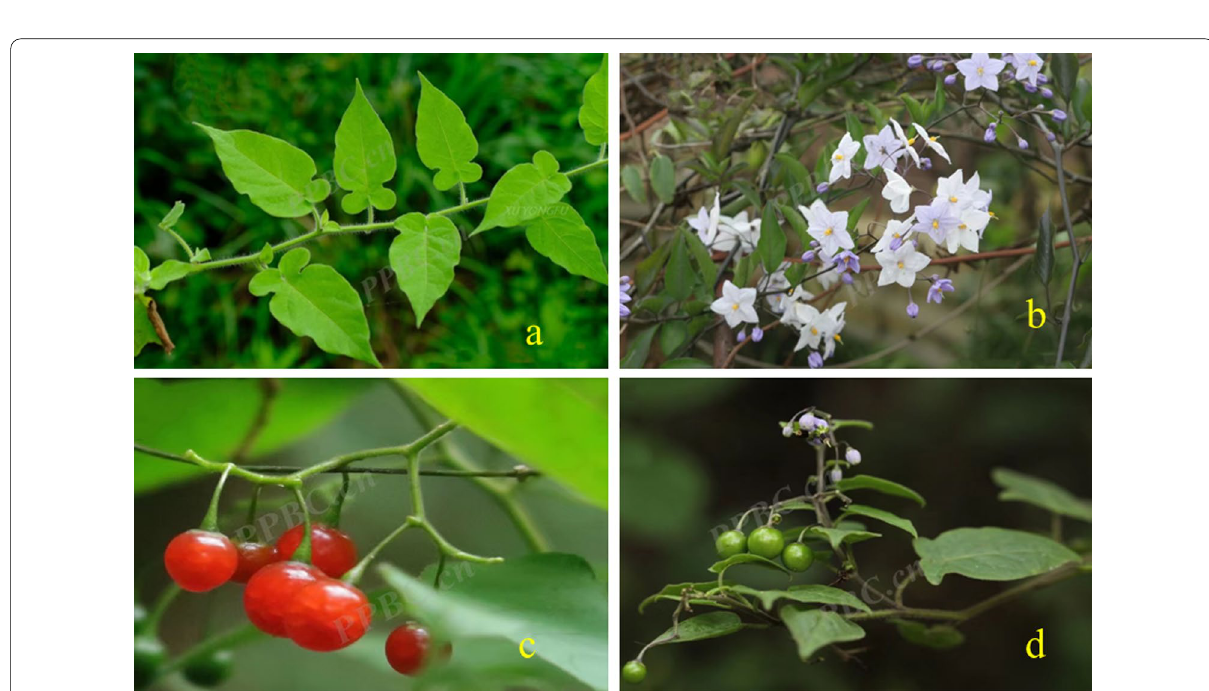
Fig. 2 Plant morphology of S. lyratum , (a) leaves, (b) flowers (c) fruits (d) the whole plant [data originated from the Plant Photo Bank of China (http:// ppbc. iplant. cn/), accessed 10 April